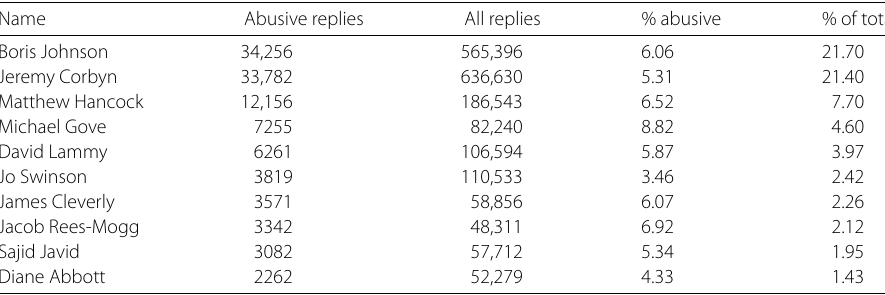
Table 4 Ten most abused candidates by